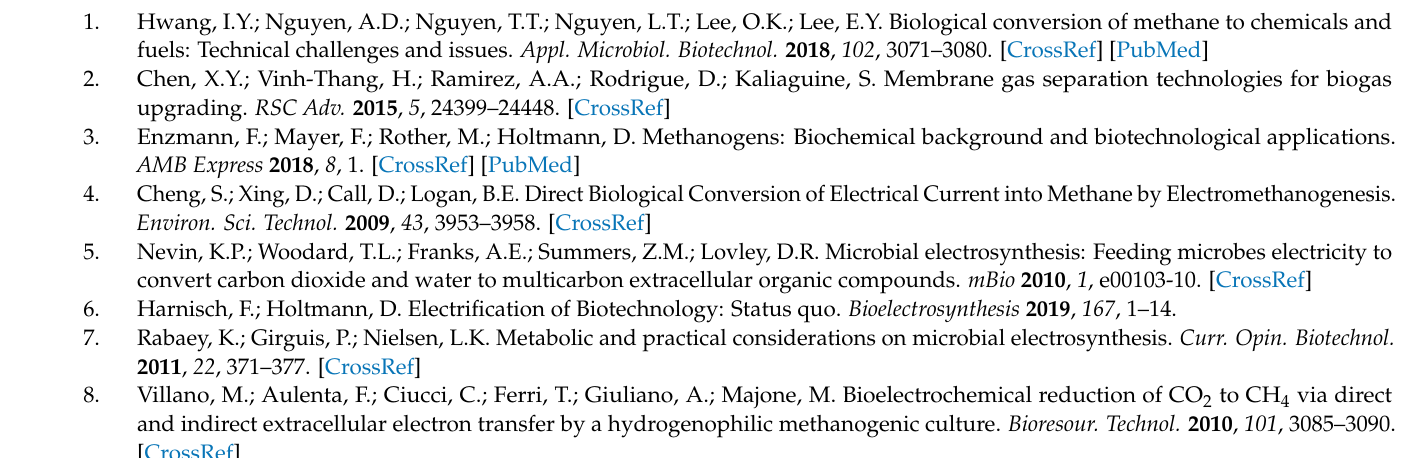
Figure S2: Element measurements at different spots of the electrode used during electromethanogen- esis with M. maripaludis KA1, Figure S3: EDX mapping of an area with deposits of the electrode used during electromethanogenesis with M. maripaludis KA1. Different elements are shown in different colors, in Table S1. Additional genes in the genome of M. maripaludis KA1 in comparison to strain